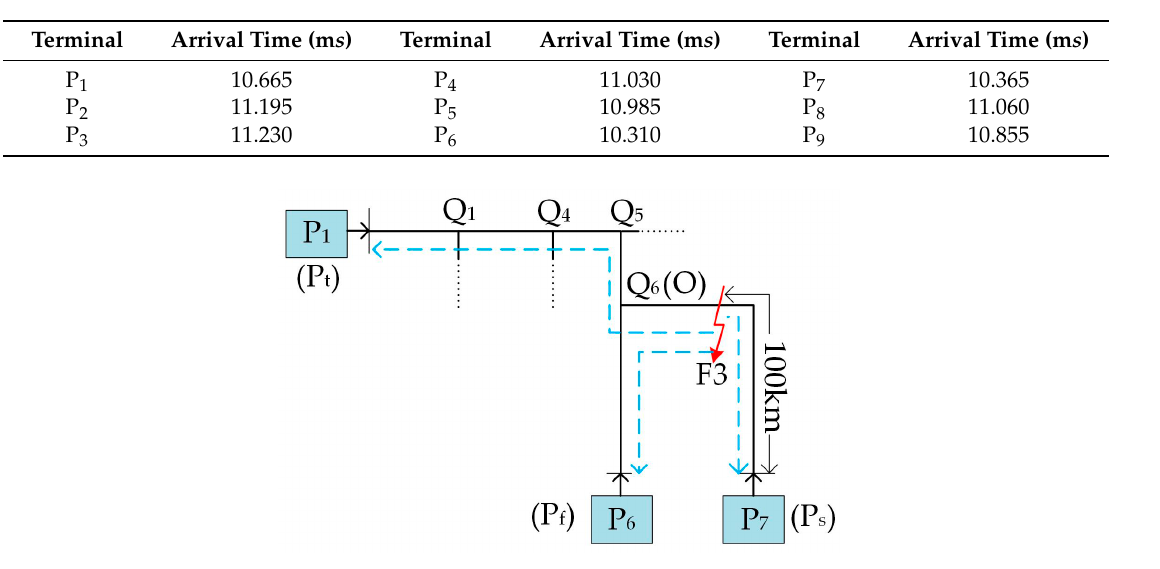
Table 6. Section identification and fault location results in different positions.